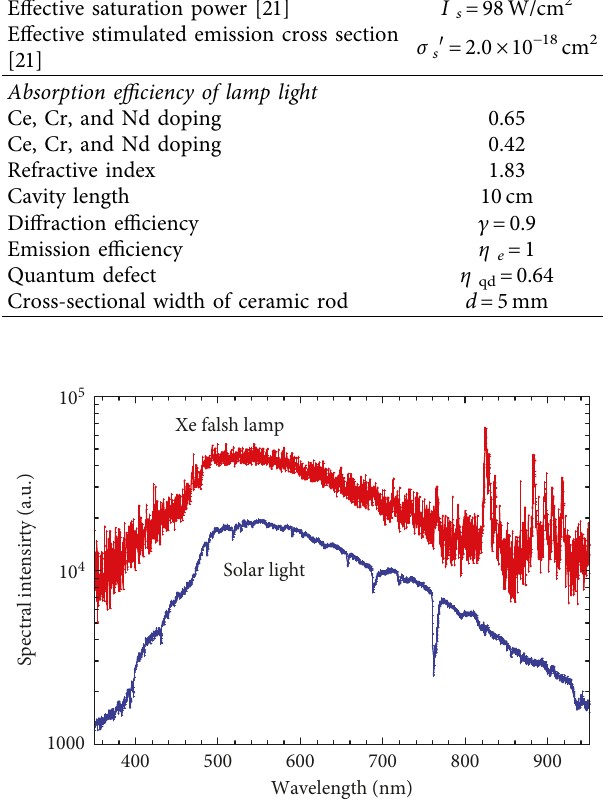
Figure 2: Spectrum of solar light and Xe flash lamp light.